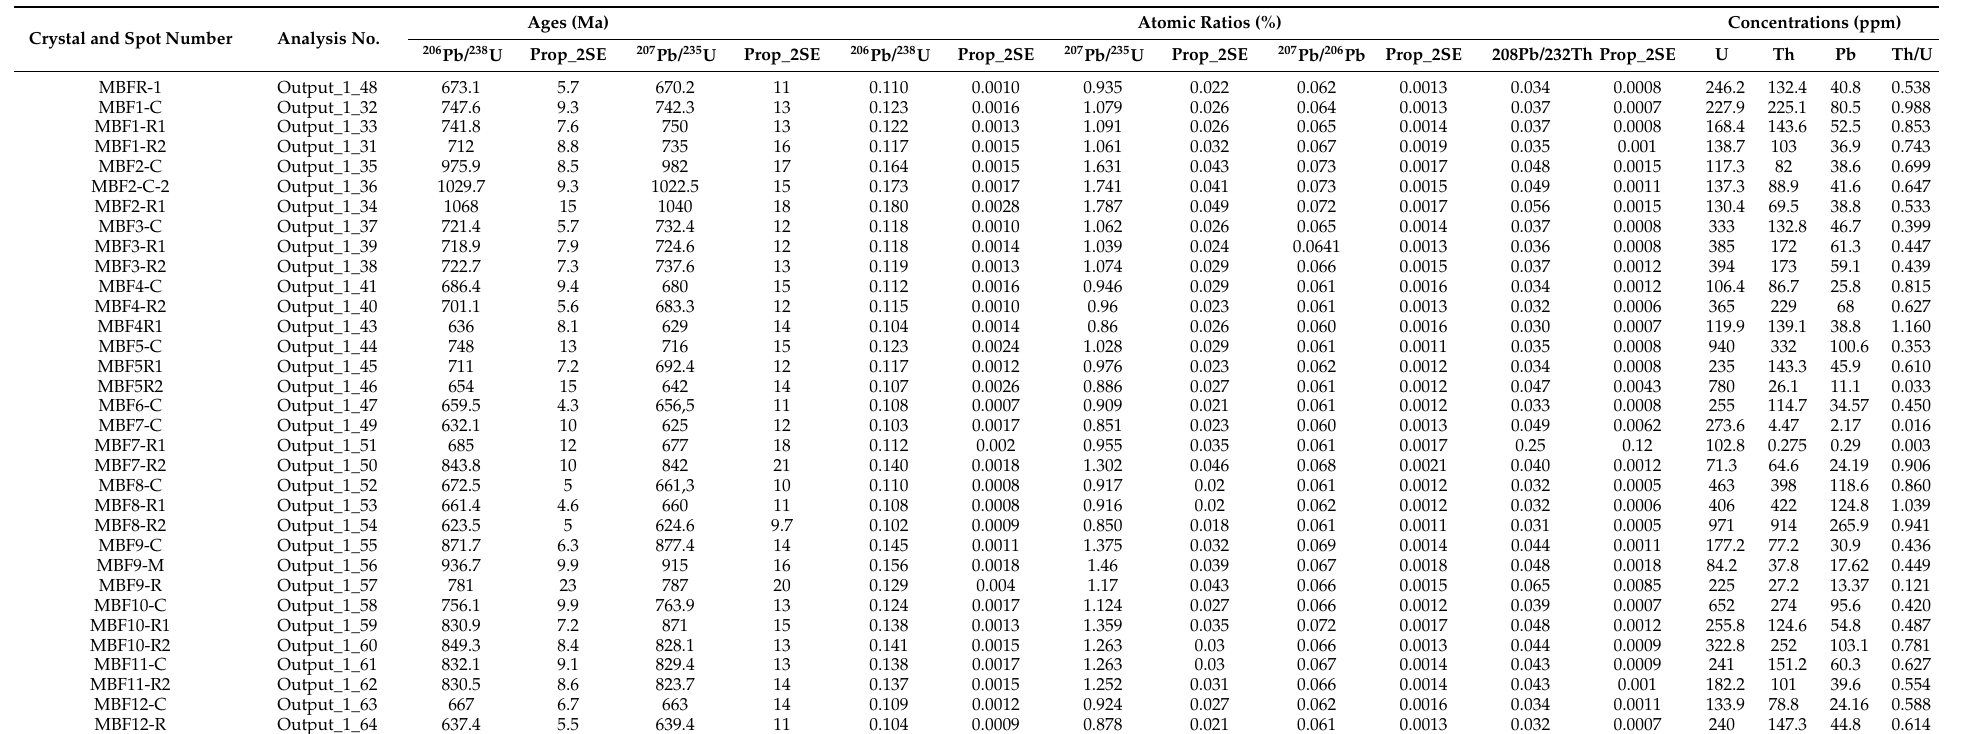
Table 4. Trace element and U-Pb isotopic results (zircon from Mboifong migmatite) with C and R in the spotted areas. Crystal and Spot